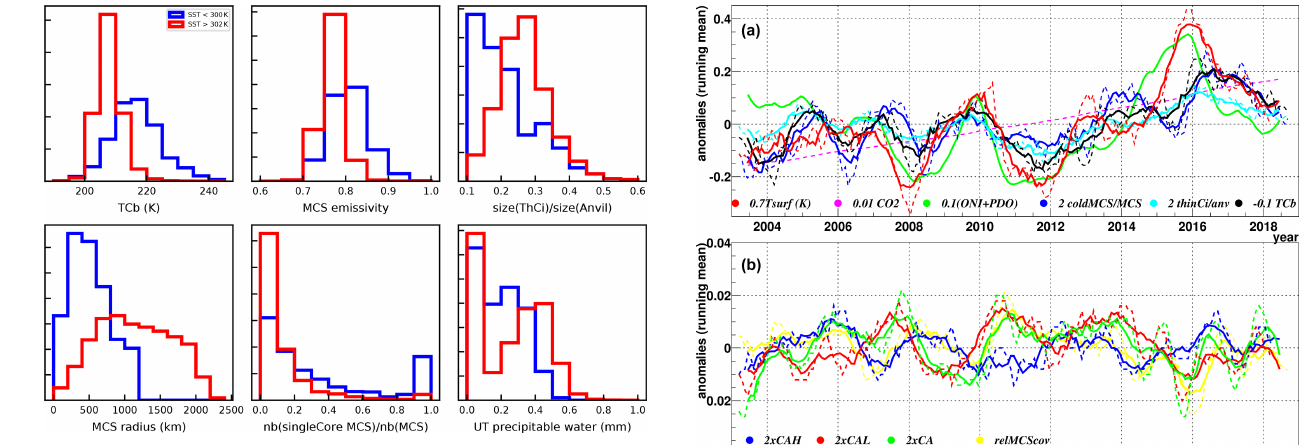
Figure 10. Normalized distributions of maritime MCS properties: near-cloud-top temperature of convective cores, emissivity of con- vective cores and cirrus anvil, relative size of thin cirrus surround- ing the anvil, radius of convective core and cirrus anvil, fraction of MCSs with single convective core and upper tropospheric precip- itable water, separately for systems overlying cool and warm re- gions.